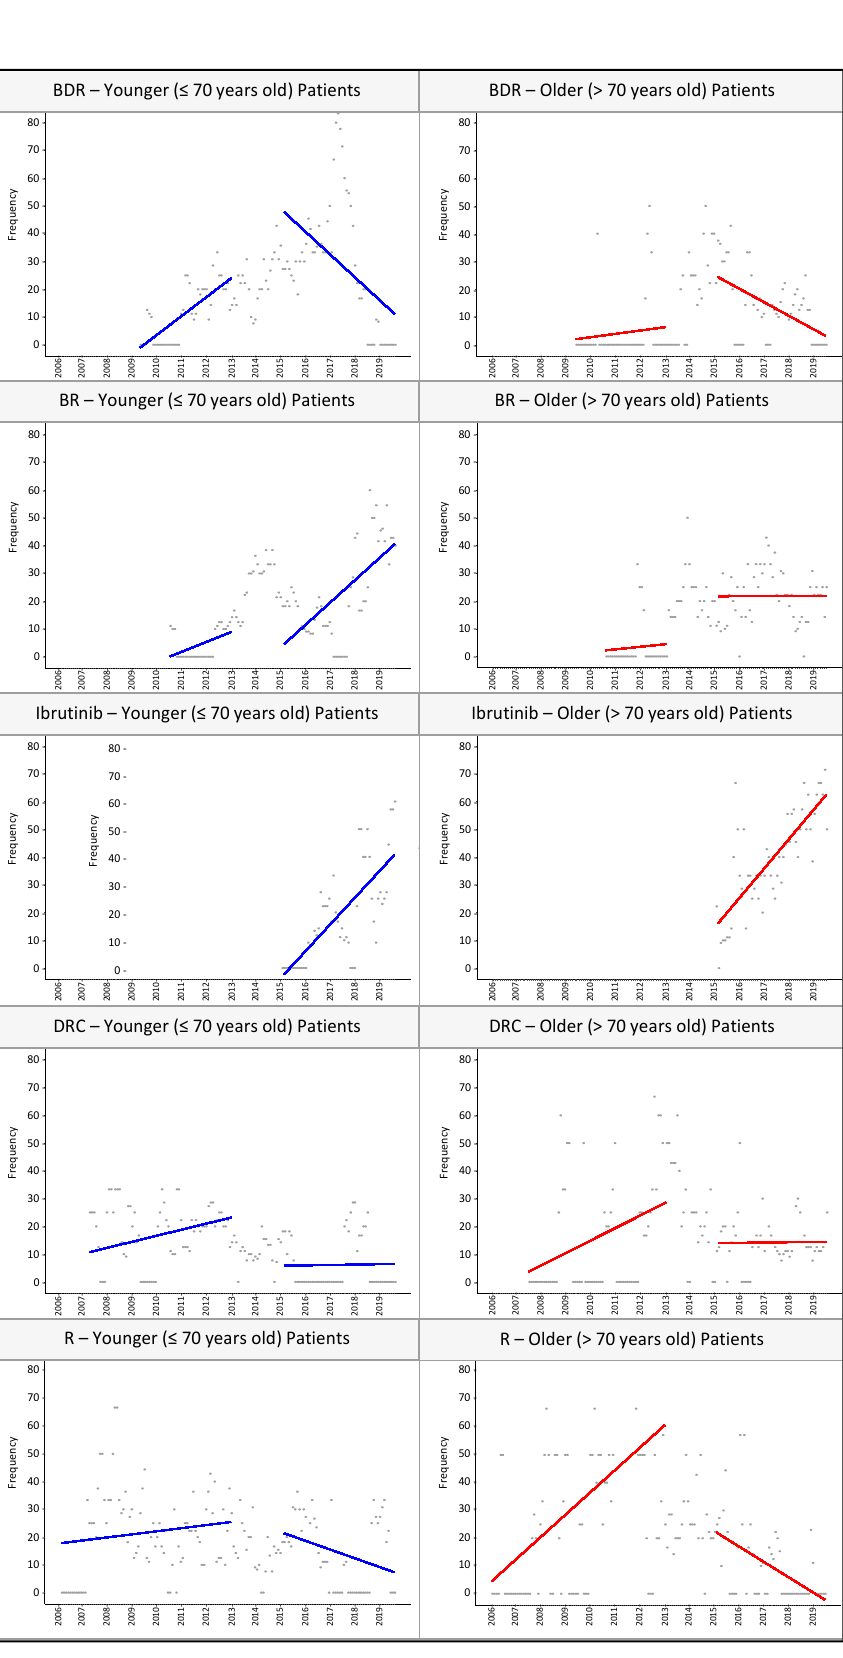
Figure 3. Treatment utilization trends in BDR, BR, ibrutinib, DCR, and single-agent rituximab, 2006–2019. BDR: bortezomib and dexamethasone +/ − rituximab; BR: bendamustine +/ − rituximab; DRC: dexamethasone, rituximab, and cyclophosphamide; R: rituximab.